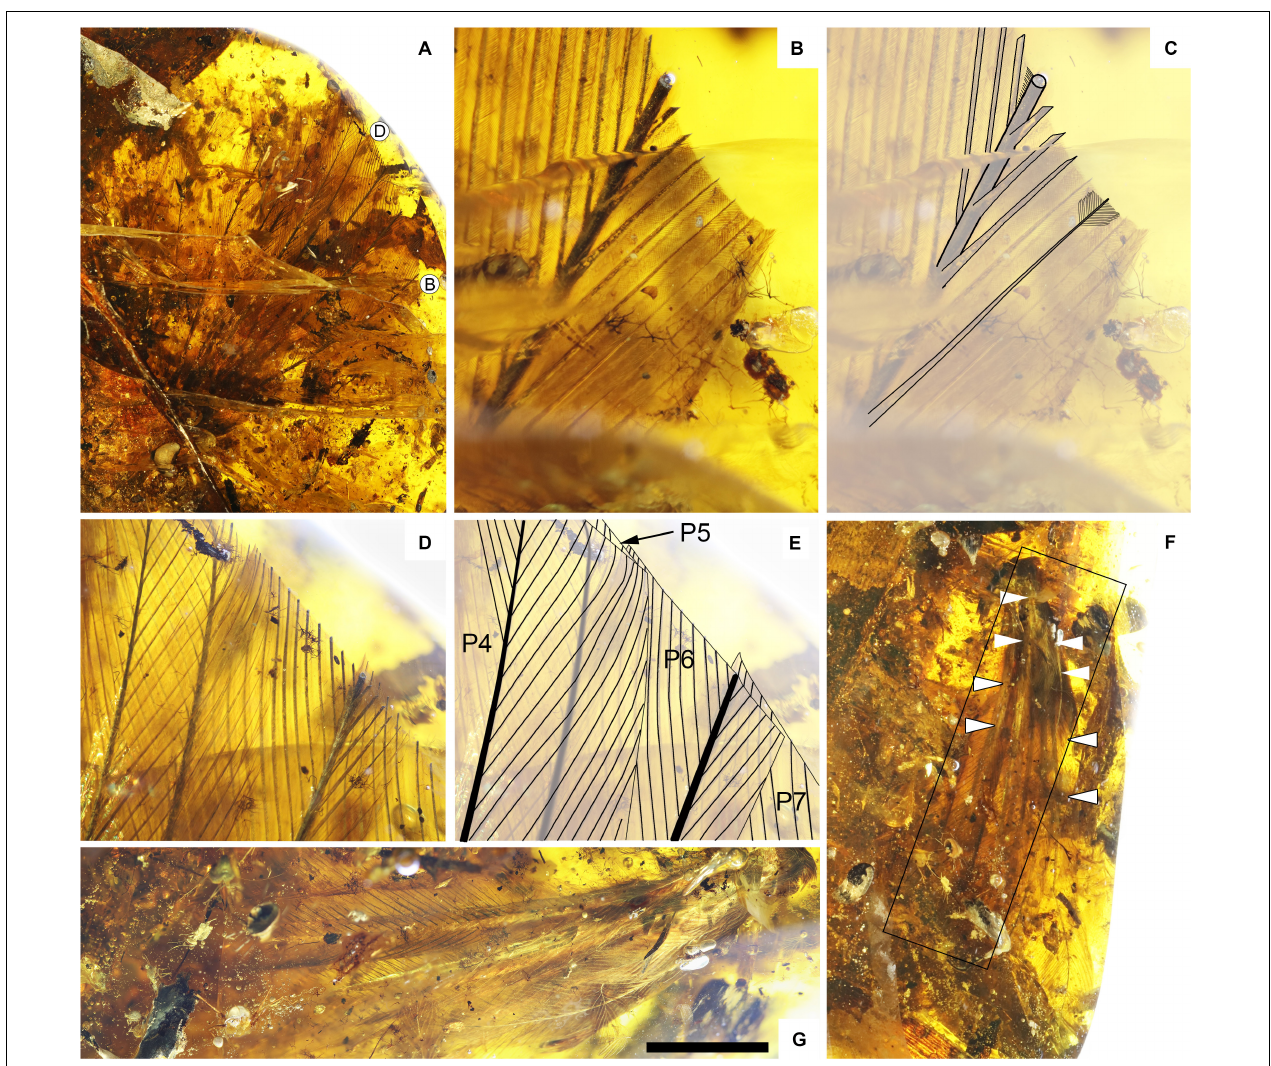
FIGURE 4 | Plumage of YLSNHM00813. (A) Overview of the left wing; (B) close-up of a barb truncated at the amber surface; (C) interpretive diagram of (B) with examples of barb rami position and barbule position; (D) close-up of remiges superimposed and truncated by the surface of amber; (E) interpretive diagram of (D) highlighting the outline of the vanes as well as the position of the rami and the rachises; (F) overview of the right wing with arrowheads (white and white with a black contour) highlighting the position of two white bands; (G) close-up of the left wing. Scale bars = A : 10 mm; B : 1 mm; D : 3 mm; F,G : 5